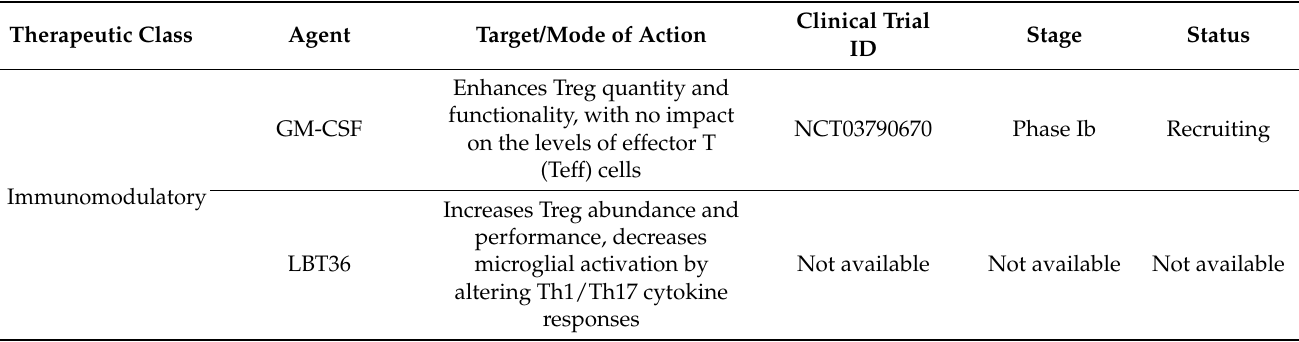
Table 2. Clinical trials of immunotherapeutic interventions involved in PD